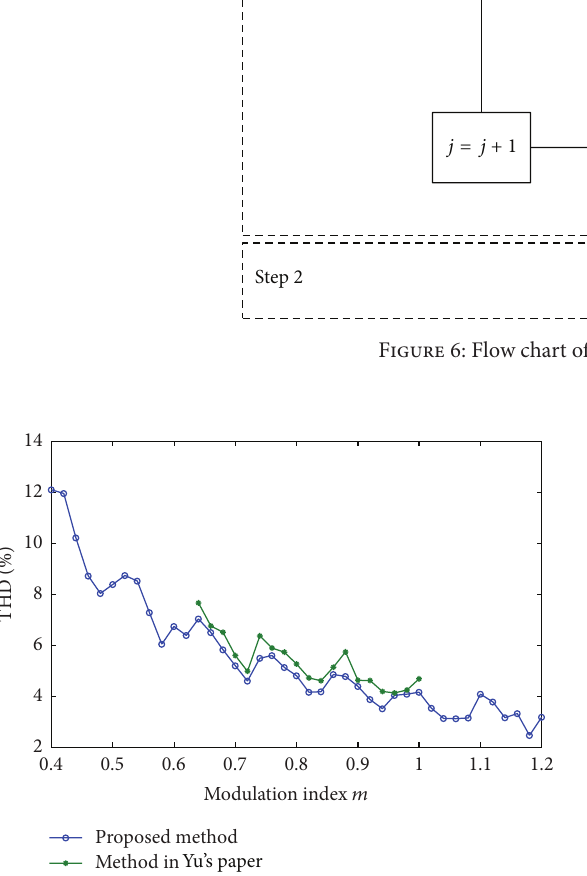
Figure 8: Comparison of calculation time between the proposed method and the previous